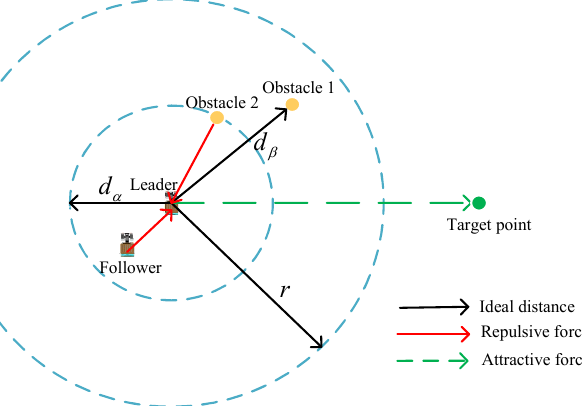
Figure 3. Schematic diagram of the potential field of the leader. Followers will not be attracted by the target point. d α Indicates the minimum distance between AGVs. d β Indicates the minimum distance between an AGV and an obstacle. r is the maximum communication radius of the